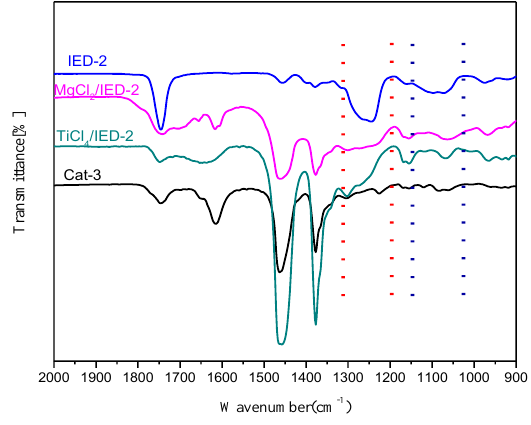
Figure 6. Stretching Vibration of Carbonate Group and Ether Bond of IED in TiCl 4 · IED-2, MgCl 2 · IED-2 and Cat-3 (Nujol mull sample).